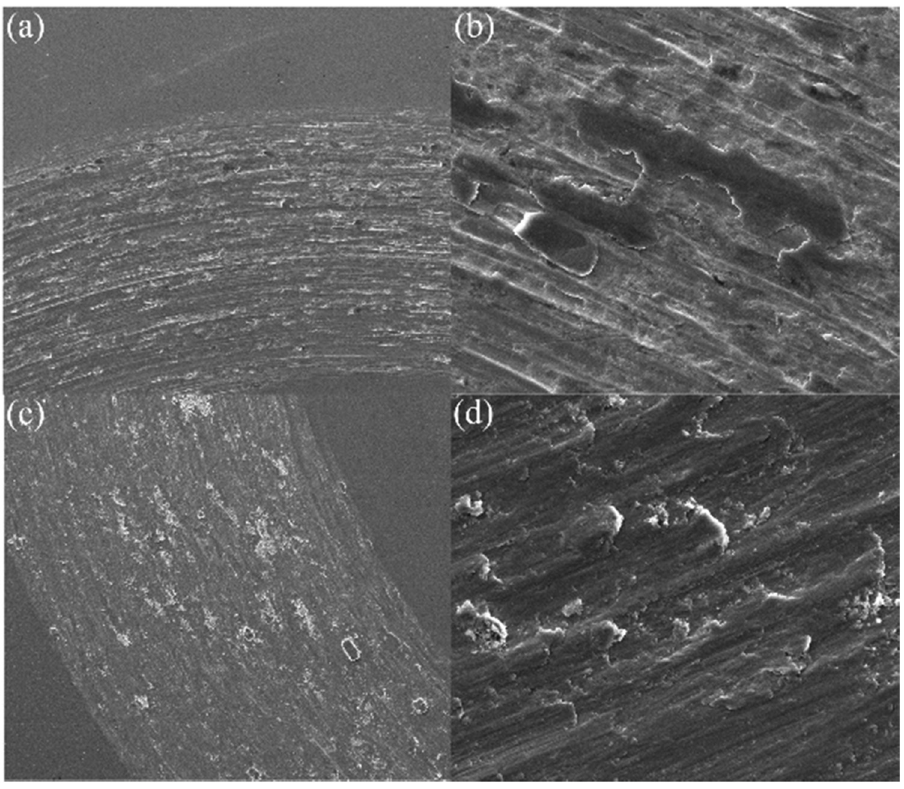
Figure 5: SEM micro - morphology of ( a ) and ( b ) SUB 27SiMn steel, CL ( c ) and ( d ) after - wear test.